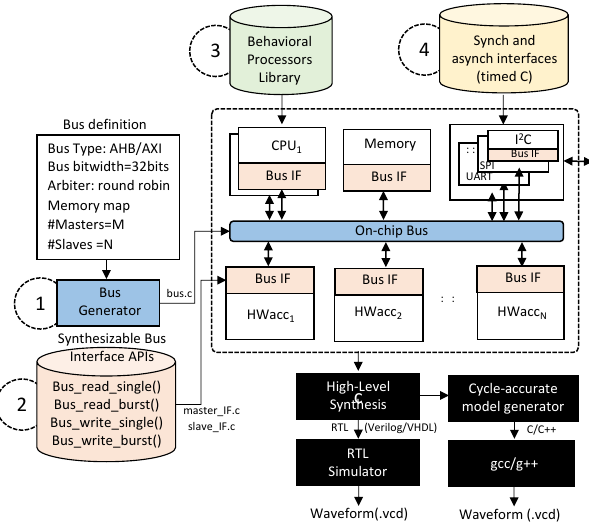
Figure 3. Overview of the proposed flow and target architecture.